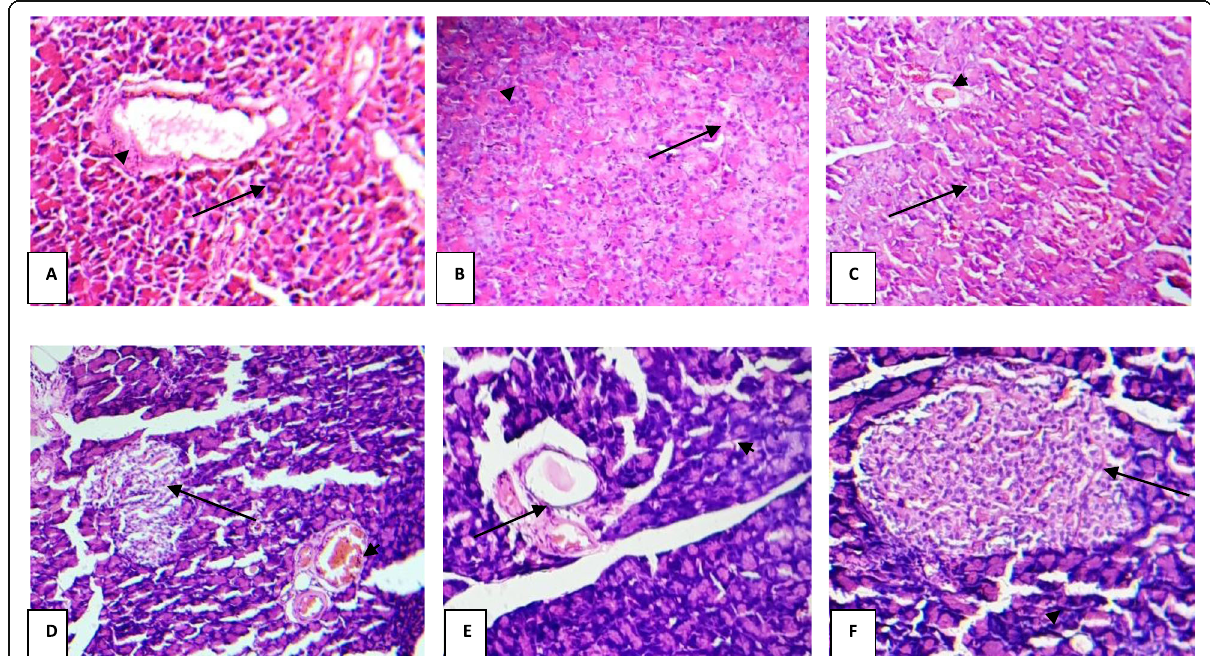
Fig. 1 Effect of n-Hexane leave extracts of J. gossypiifolia on the pancrease. A= untreated group: Pancrease features show several acinar cells having islet-cells with mildly despaired pyknotic Nuclei via Lymphocytic infiltrates and visible intralobular duct appearing fatty. B=10mg/kg Gliberclamide: Pancrease reveals features with several acinar cells in islet-cells showed mildly despaired pyknotic nuclei with mild dispersed Lymphocytic infiltrates. C=Normal control: Pancrease reveals secreterory acini pancreatic islet. Histology reveals intralobular duct on low power. D=30mg/kg extract: Pancrease reveals secreterory acini with bulky pancreatic islet. The histology reveals intralobular duct. E=50mg/kg extract: Pancrease character showed certain acinar cells having islet-cells exhibiting mildly despaired pyknotic nuclei. The histology reveals intralobular duct. F=100mg/kg extract: Pancrease reveals secreterory acini with bulky pancreatic islet. The nucleus appears pyknotic. Using haematoxylin-eosin dye with X 40